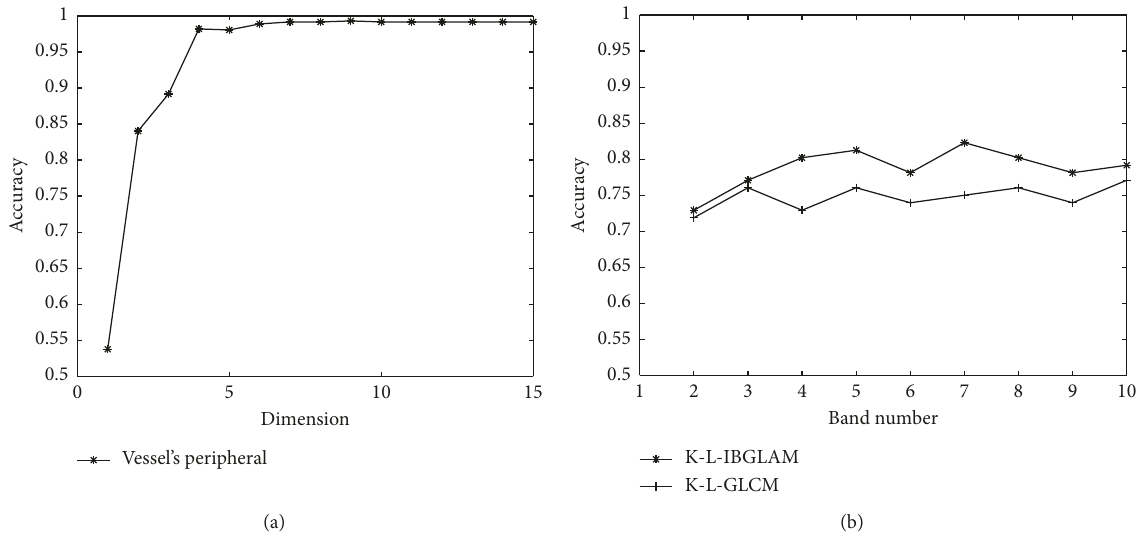
Figure 21: Comparison of proposed method vs. other methods: (a) vessel peripheral spectral extraction method; (b) IBGLAM and GLCM